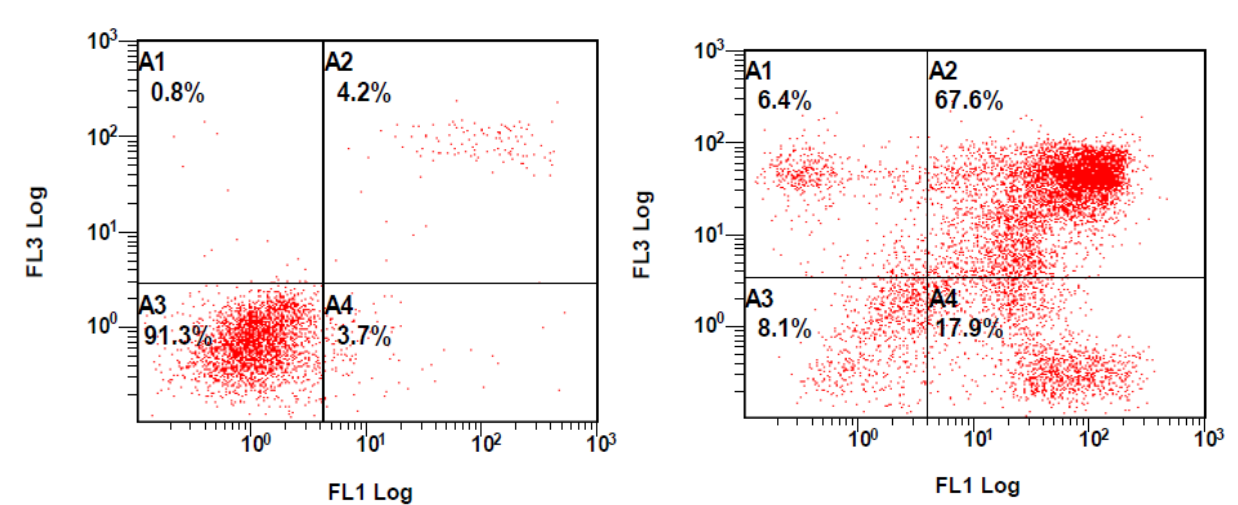
Figure 5. Assessment of apoptosis induction in A549 cells treated with garcinamine D: ( left ) control and ( right ) treated A549 (IC 50 , 48 h). Quarters (A4) represent early apoptosis, (A3) viable cells, (A2) late apoptosis, and (A1) necrosis. The rate of apoptosis was determined by flow cytometry, using the Annexin V-FITC/PI staining assay.